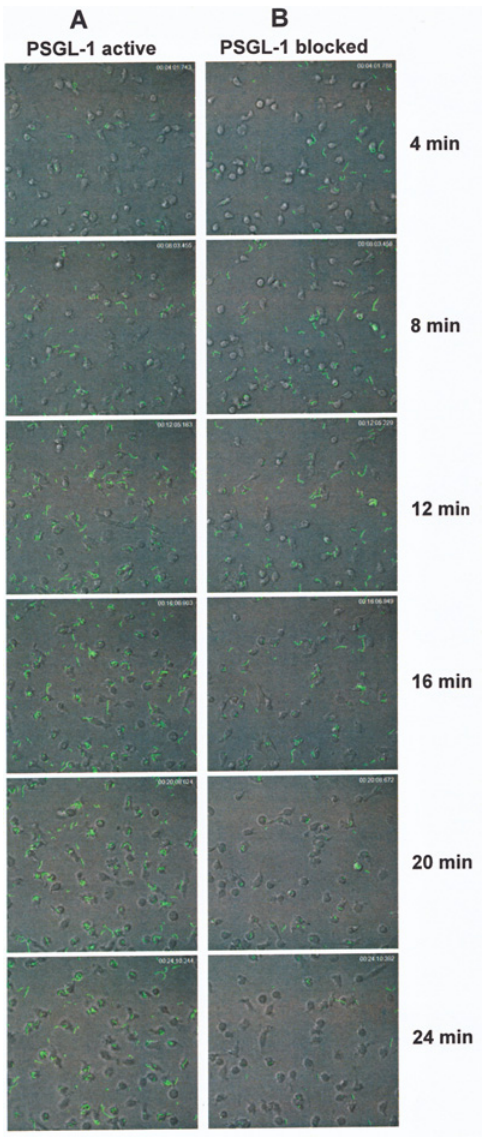
times by live imaging confocal microscopy and environmental control (A) Phagocytosis of D39 strain using HL-60 cells with the PSGL-1 active. (B) Phagocytosis of D39 strain by HL-60 cells with the PSGL-1 blocked after incubation with